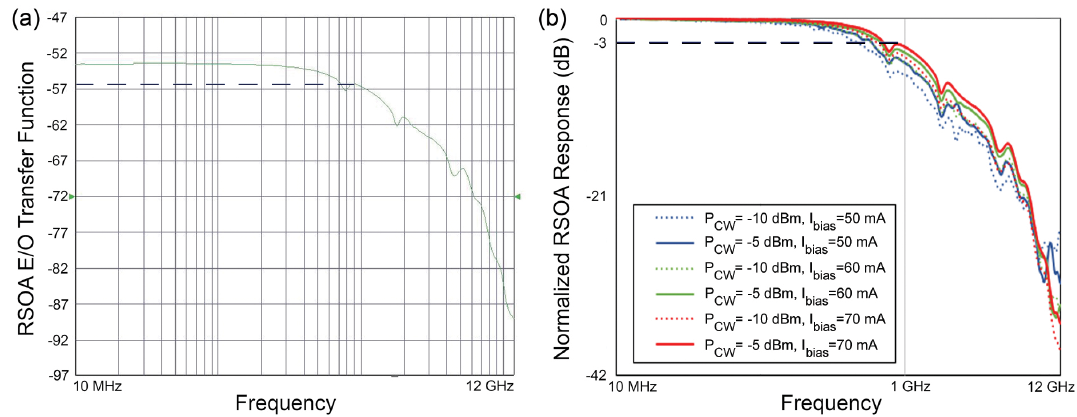
Figure 4. RSOA E/O response measured for ( a ) constant and ( b ) varying CW input power and DC bias. The dashed line indicates the 3-dB electrical modulation